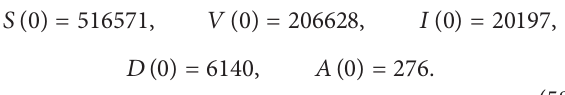
that 3.2 million blood samples were tested in Yunnan in